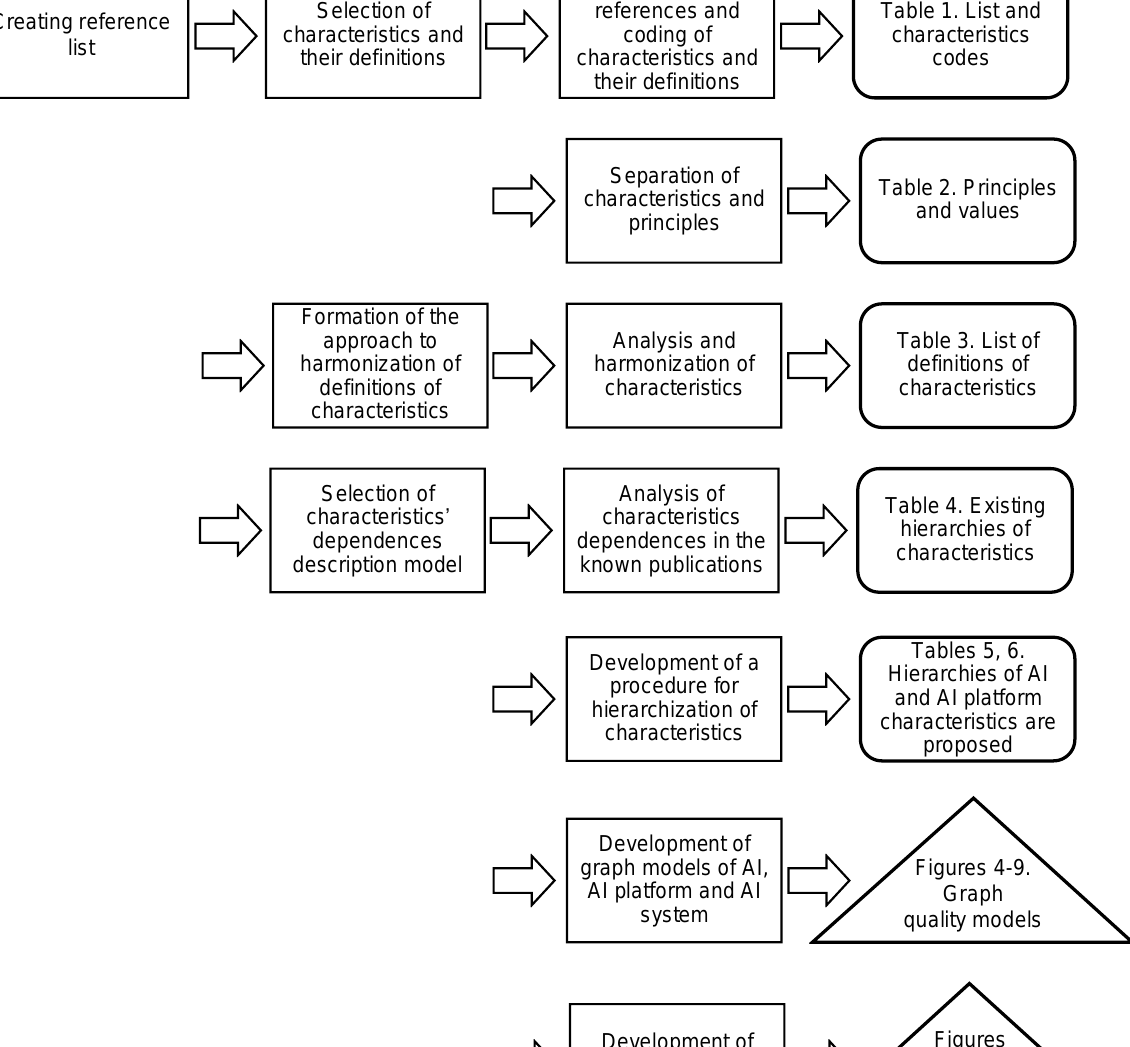
Table 1. List and characteristics